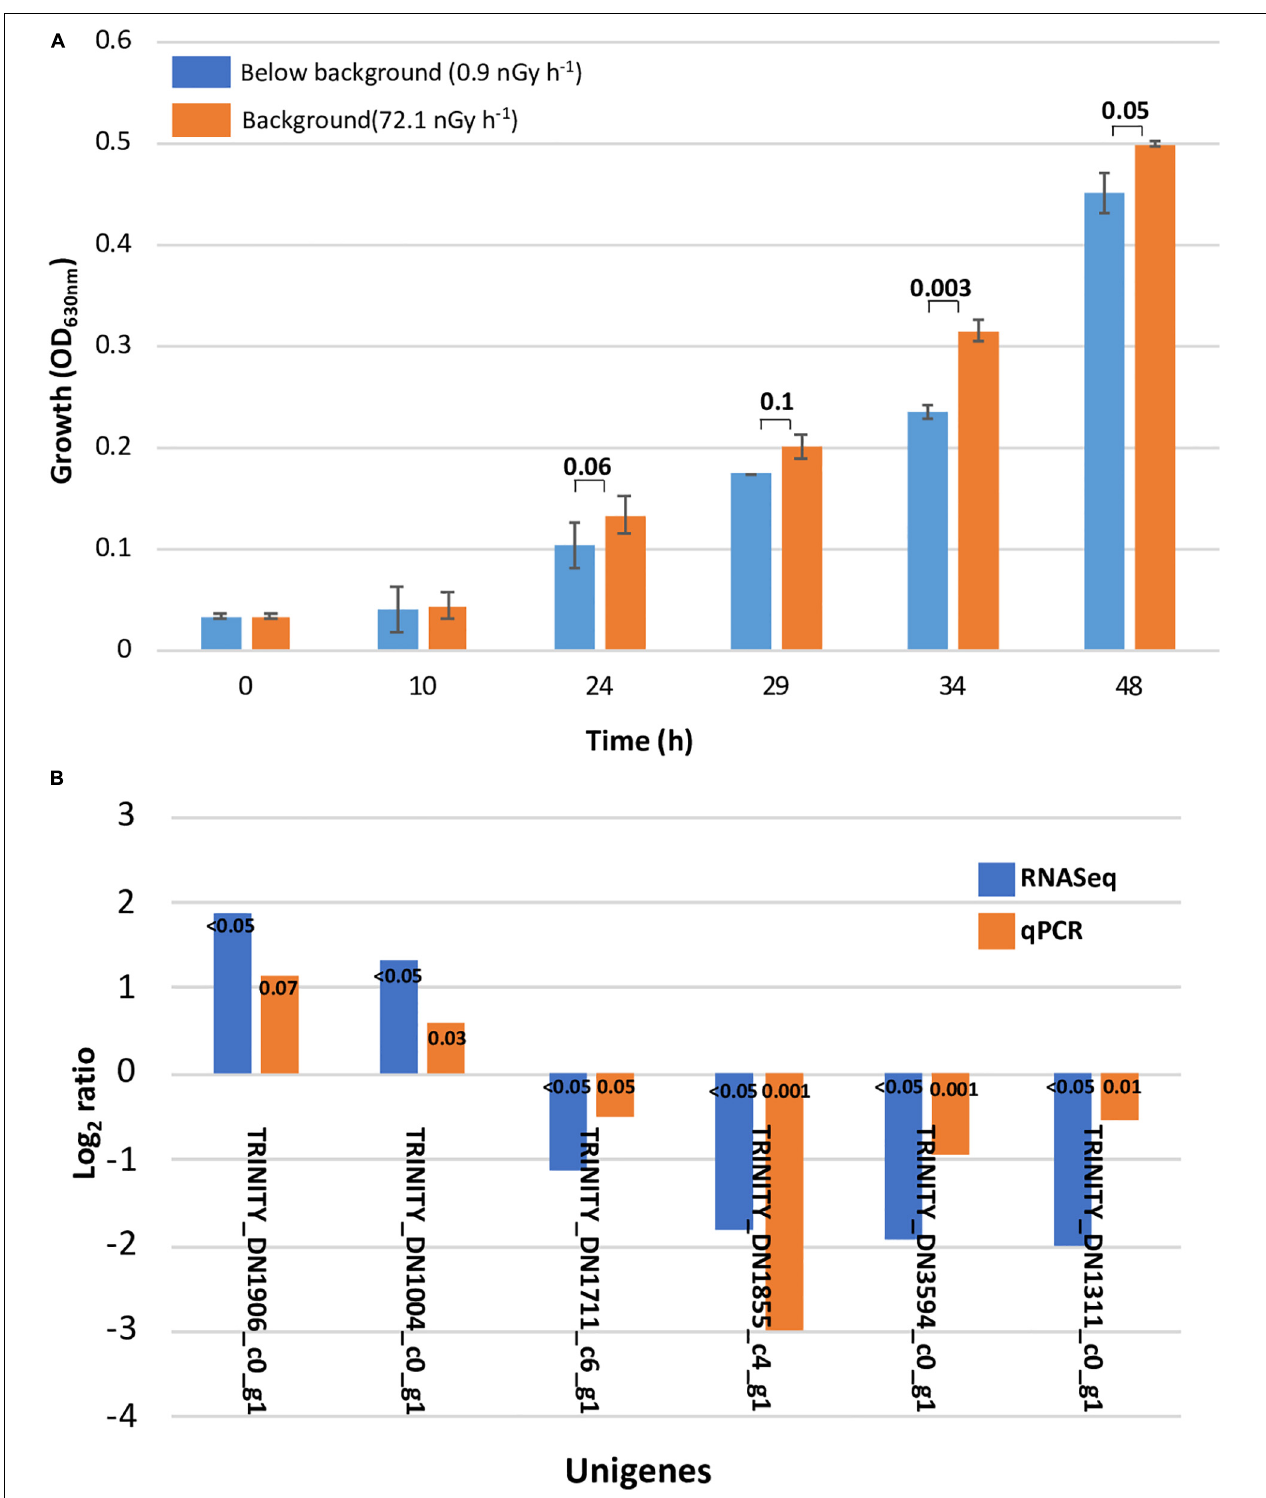
FIGURE 1 | Slower growth and qPCR validation. (A) Slower growth in Deinococcus radiodurans cultures grown in the absence of background levels of ionizing radiation. Bars show standard error bars and a p -value significance number. (B) Transcriptome analysis validation with differential gene expression calculated using qPCR. The unigenes used as target and reference and their function are described in Supplementary Table 1 (ST1).